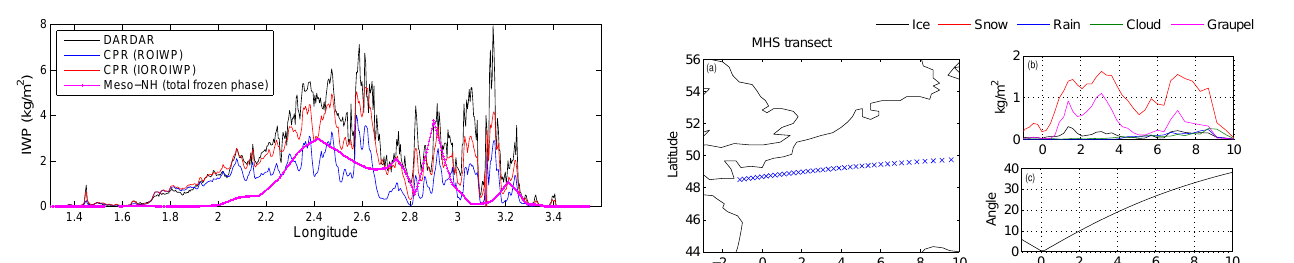
Figure 4. CloudSat CPR ice mass content as retrieved by DAR- DAR, CWC-RO and CWC-IO-RO. The total frozen mass contents (graupel + ice + snow) modelled by Meso-NH are shown for refer- ence.